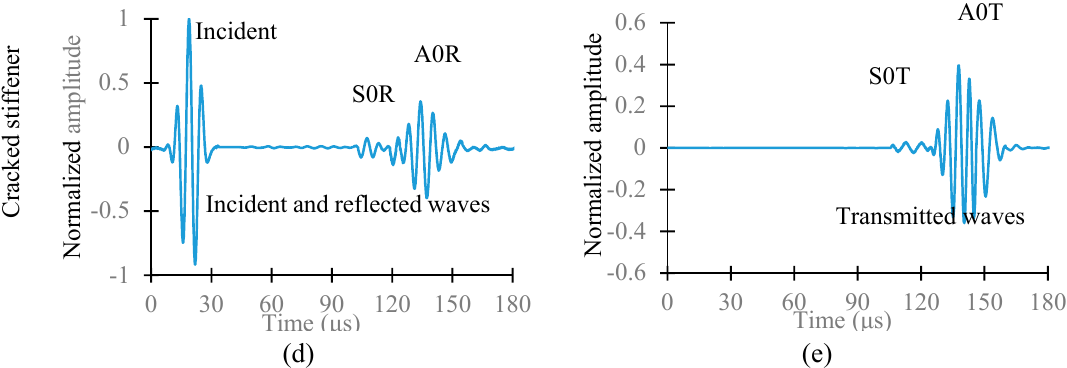
Figure 10. ( a ) Schematic diagram of the sensing locations; ( b ) incident and reflected Lamb waves from pristine stiffener; ( c ) transmitted Lamb waves from the pristine stiffener; ( d ) incident and reflected Lamb waves from cracked stiffener; ( e ) transmitted Lamb waves from cracked stiffener.